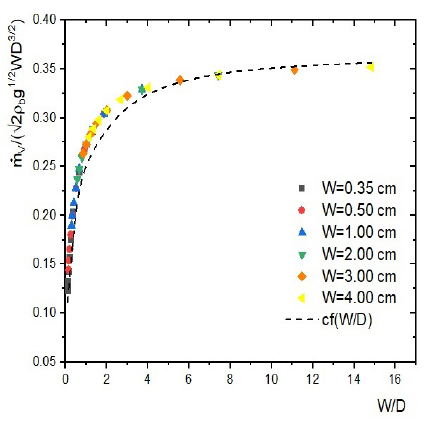
Figure 2. Dimensionless plot of Eqs. (15) (dashed curve) and (16) (symbols) as a function of W / D . The values of W and D used in Eq. (16) were given in previous paragraphs: low (large) values of W correspond to vertically (horizontally) elongated slots. The best fit of formula (15) to symbols was obtained with c = 0 .